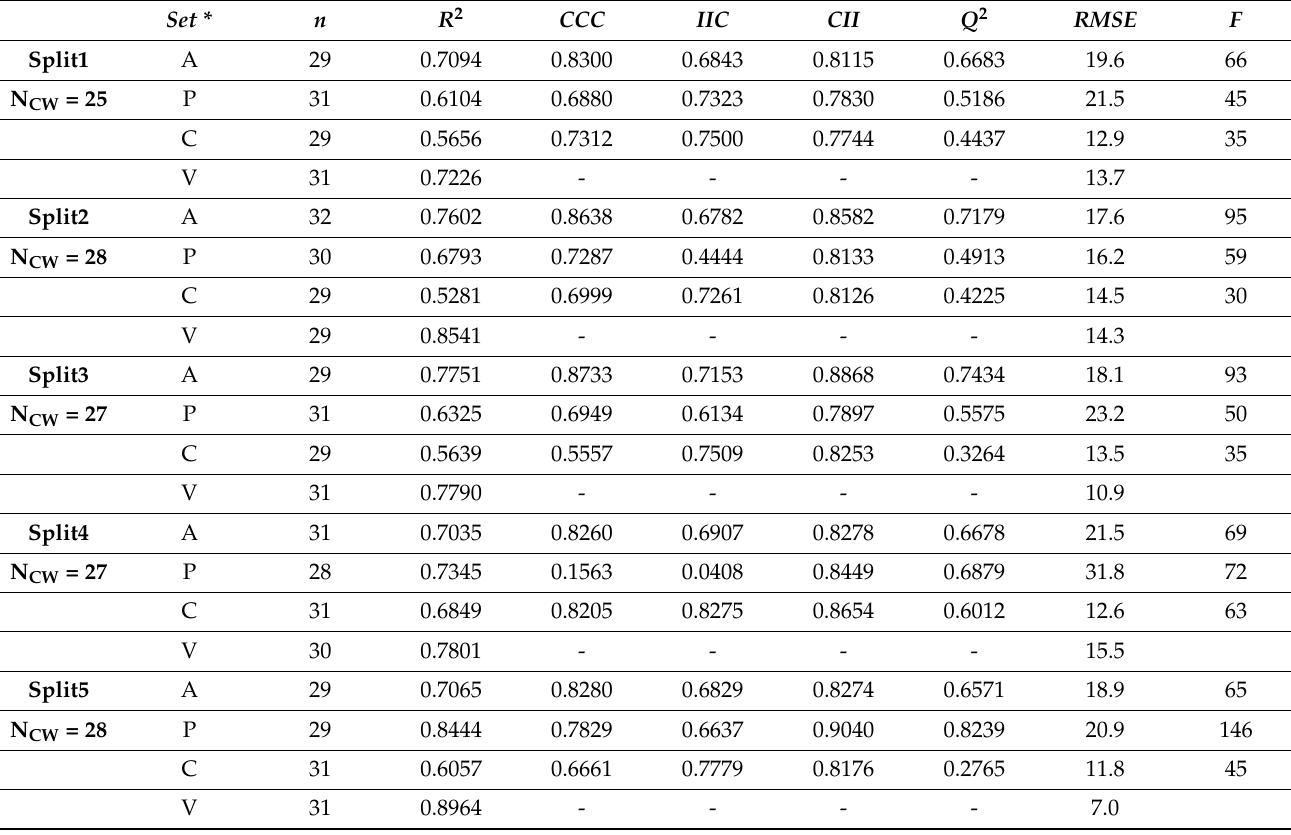
Table 1. The statistical characteristics of models for cell viability were observed for five random splits.